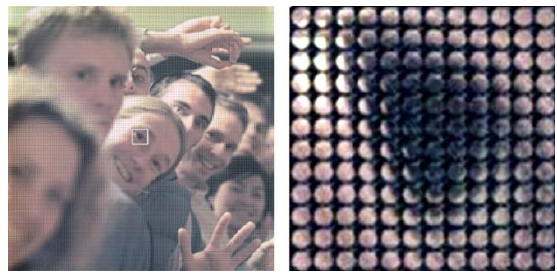
Figure 2. Plenoptic image and details from the white square in the plenoptic images